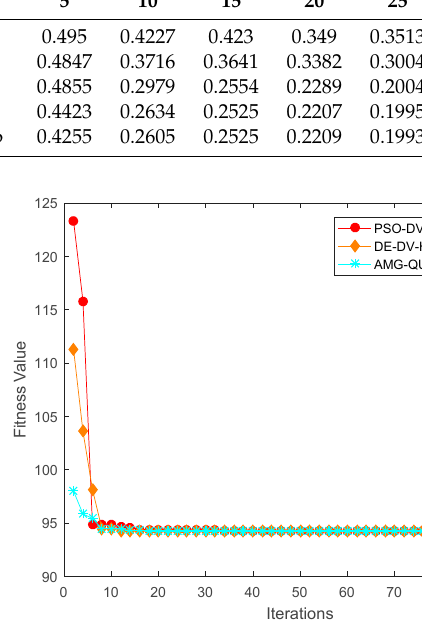
Figure 8. Comparison of convergence curve of the applied AMG-QUATRE with particle swarm optimization (PSO) and differential evolution (DE) methods for single simulation (Number of sensor node 200, Number of anchor node 40, Communication range 20).